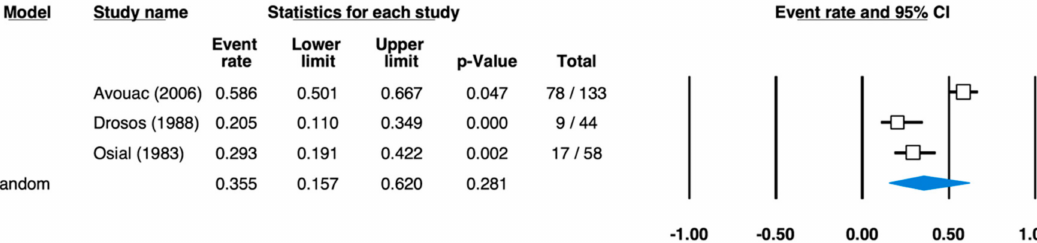
Figure 5. Forest plot for the pooled effect estimates of prevalence in scleroderma—oral mucosa symptoms (heterogeneity: I-squared = 91.958; tau-squared = 0.835, p = 0.000).